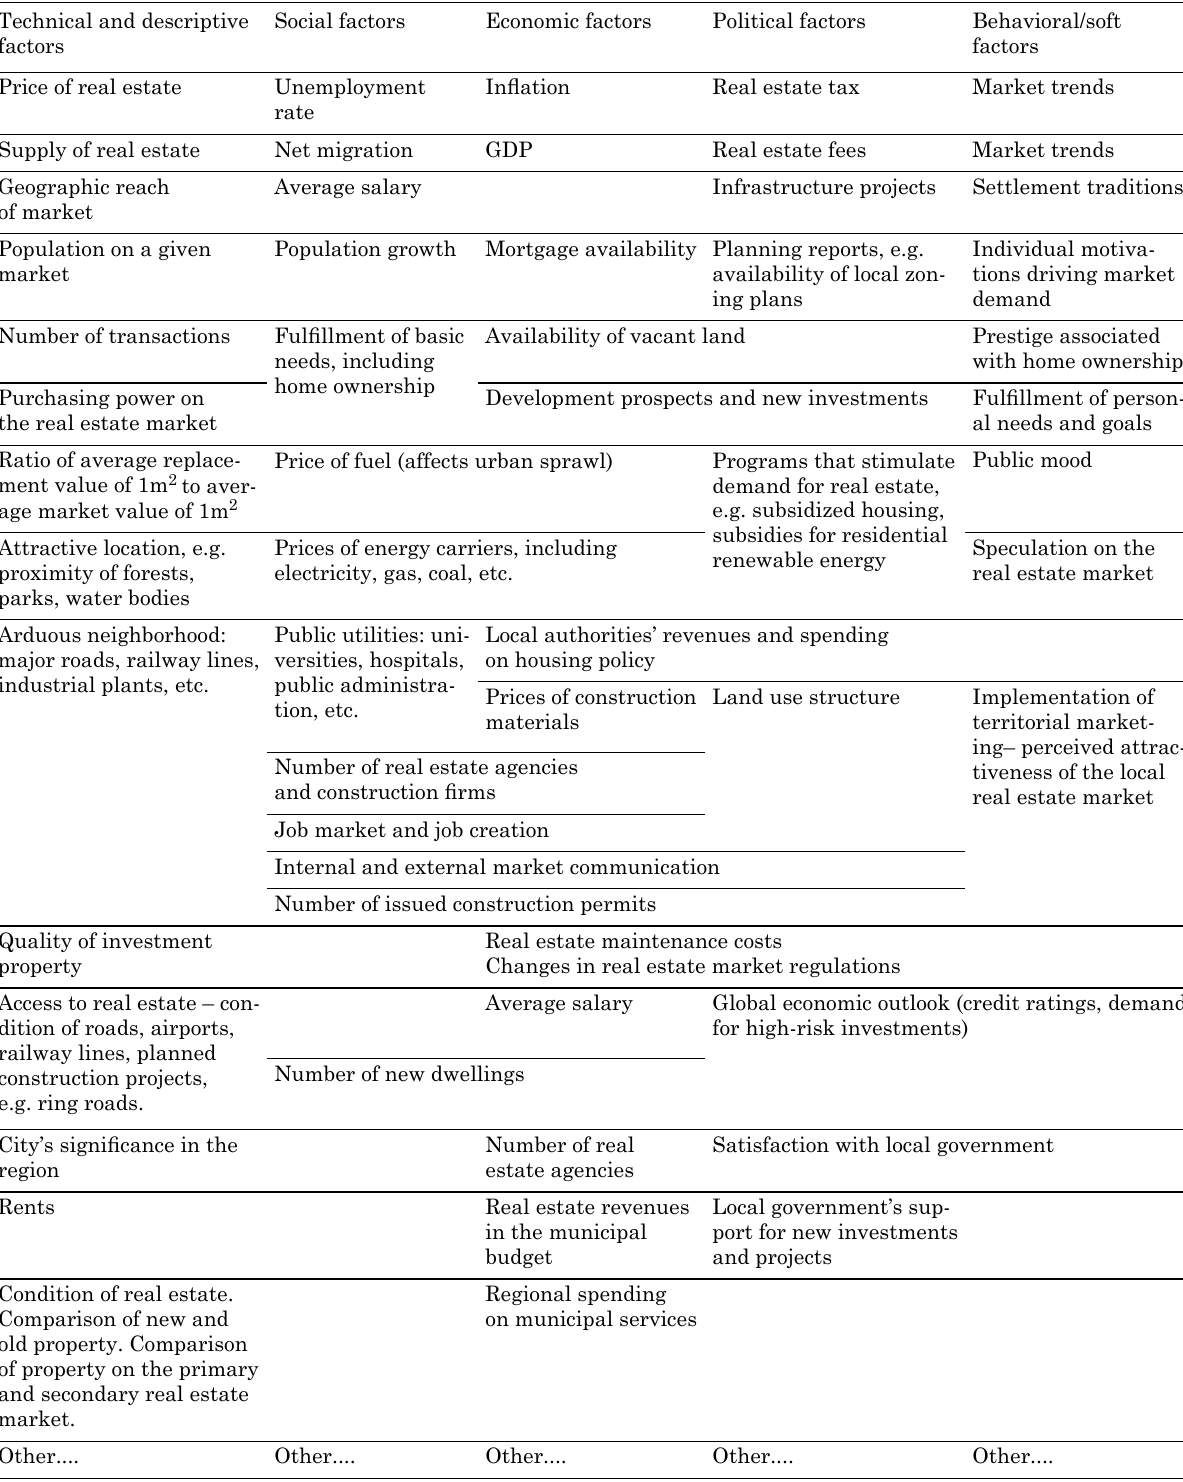
Table 2. Knowledge base of the residential property market Technical and descriptive